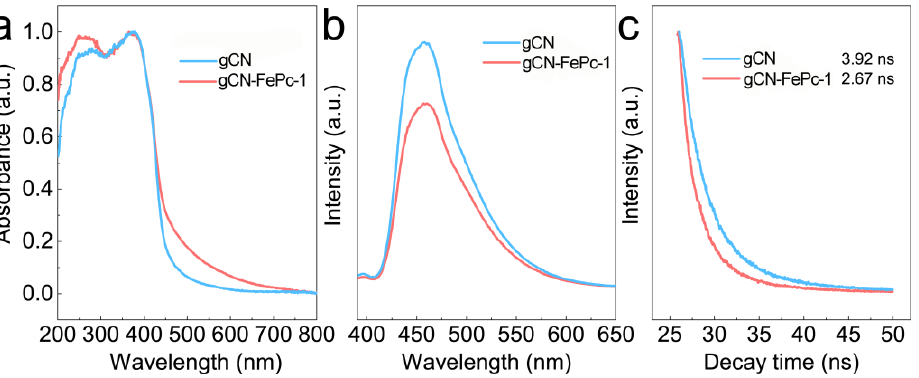
Figure 4. UV-vis DRS ( a ), steady-state PL spectra ( b ), and time-resolved PL spectra ( c ) of gCN and gCN-FePc-1.